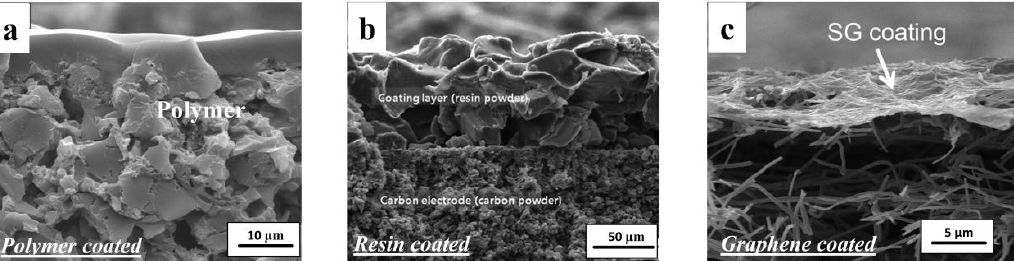
Figure 3. SEM images of three typical composite electrodes. ( a ) Carbon electrode coated with PVA/SSA polymer solution, copyright Elsvier, 2010; ( b ) composite carbon electrode coated with resin powder, copyright Elsvier, 2012; ( c ) Sulfonated graphite (SG) carbon nanofibre composite. Reproduced with permission from [27,28,35], copyright John Wiley and Sons, 2015.